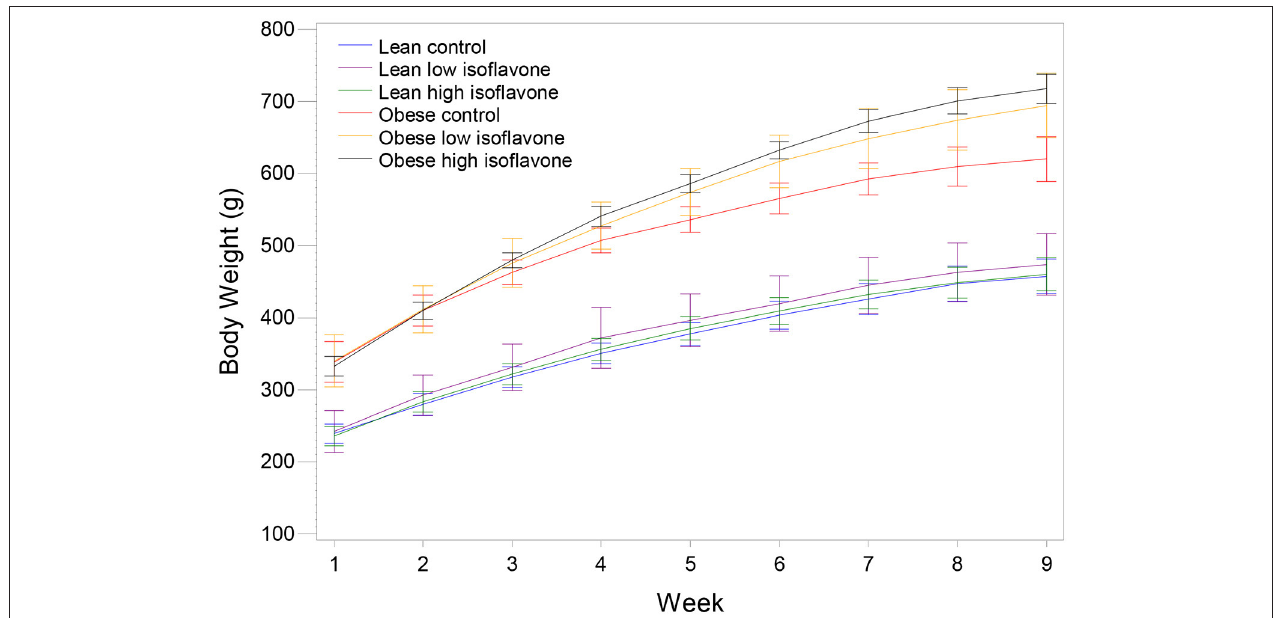
FIGURE 1 | Mean body weight and standard deviation of lean and obese rats on the control and soy protein concentrate diets with low and high isoflavones content. N = 7 rats/group.